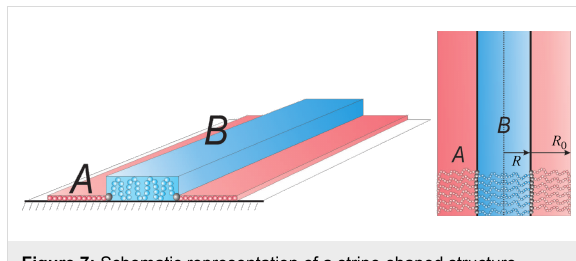
Figure 7: Schematic representation of a stripe-shaped structure.